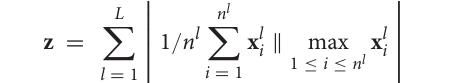
where the W l , 0 ∈ R m × p , and the W l , 1 ∈ R p × 1 are the